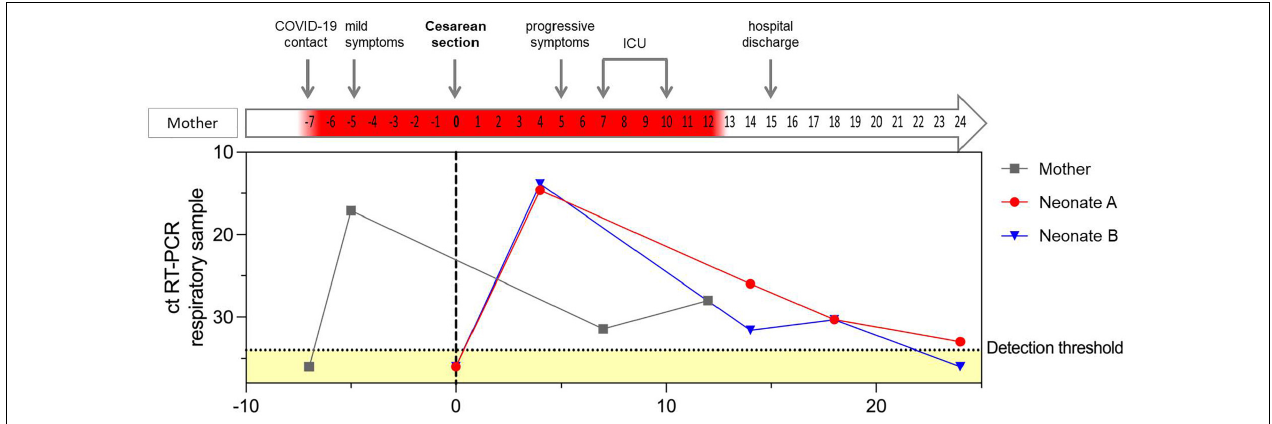
FIGURE 1 | RT-PCR cycle threshold values for SARS-CoV-2 in respiratory samples of the mother and both neonates in relation to maternal clinical course. The dotted horizontal line indicates the detection threshold set at 34, distinguishing between positive and negative (marked as yellow) RT-PCR results. Negative RT-PCR results are displayed as ct values of 36. Day of cesarean section is defined as day 0, represented with a gray, vertical, dotted line. Positive RT-CPR results of the mother’s respiratory samples are highlighted in red in the arrow illustrating the maternal clinical